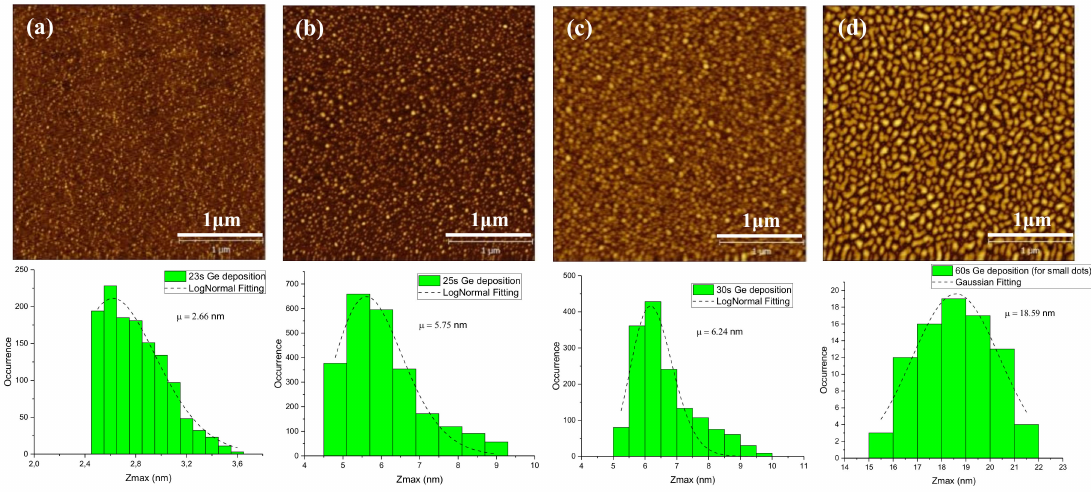
Figure 4. Atomic force microscopy (AFM) images and histogram of Ge height size distributions graphs for deposition time: ( a ) 23 s, ( b ) 25 s, ( c ) 30 s, ( d ) 60